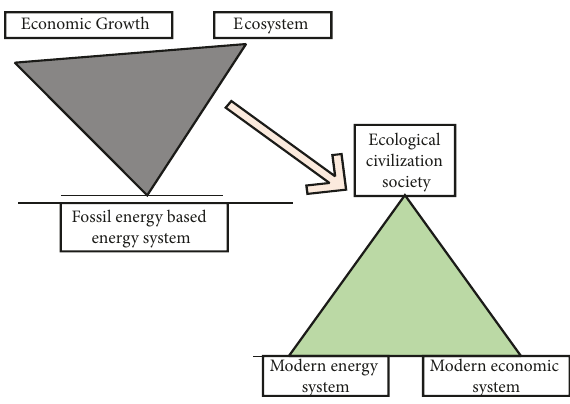
Figure 2: Triangle of energy, economy, and